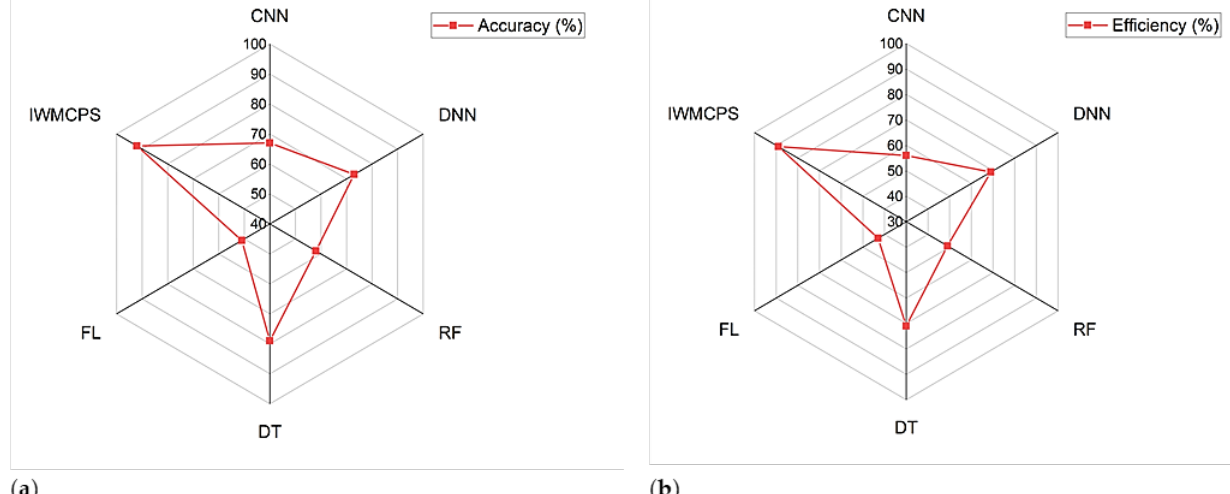
Figure 7. ( a ) Computation time analysis of the existing CPS model and ( b ) computation time analy- sis of the proposed IWMCPS model.